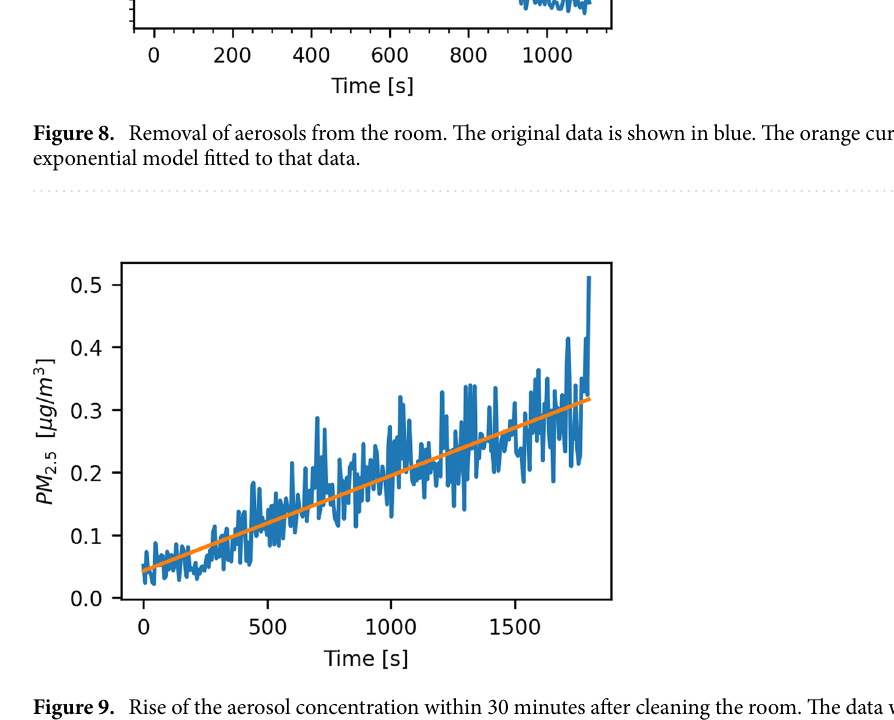
Figure 9. Rise of the aerosol concentration within 30 minutes after cleaning the room. The data was collected without any other interference. The measured concentration is shown in blue, and the fitted linear model is in